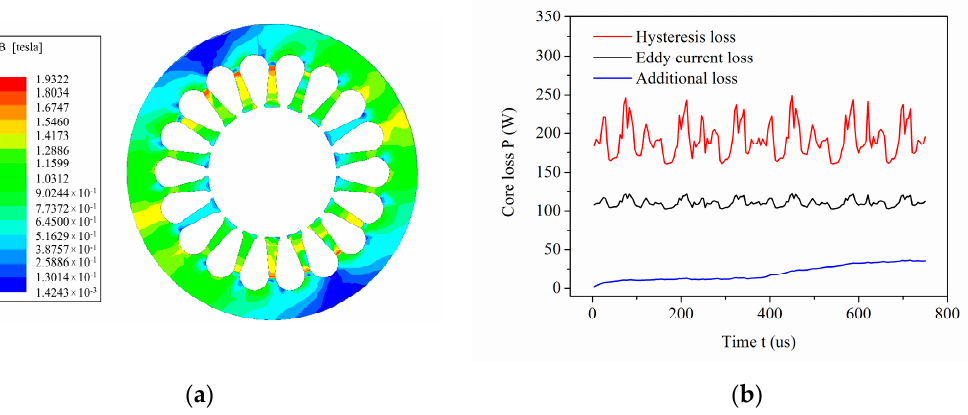
Figure 11. Magnetic induction distribution at 80,000 rpm. ( a ) Nephogram of magnetic induction. ( b ) Loss curve.